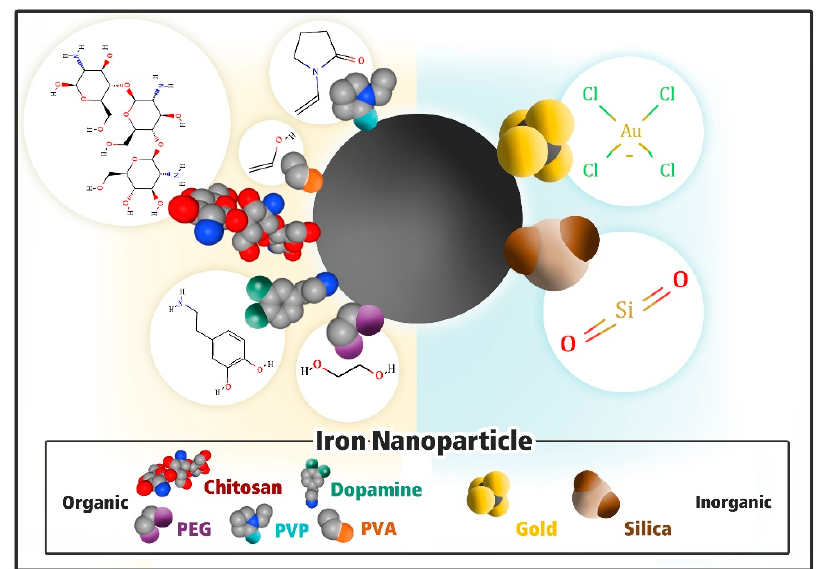
Figure 1. An iron oxide nanoparticle with different hydrophilic ligand molecules. The schematic representation of a surface modification of iron oxide nanoparticles. Left to right: organic to inorganic polyethylene glycol (PEG), polydopamine (PDA), chitosan, polyvinyl alcohol (PVA), polyvinyl pyrrolidone (PVP), gold, and silica. Molecule structures were taken from the pubchem.ncbi.nlm.gov and displayed as surfaces and modeled from their chemical structure with a space-filling model.